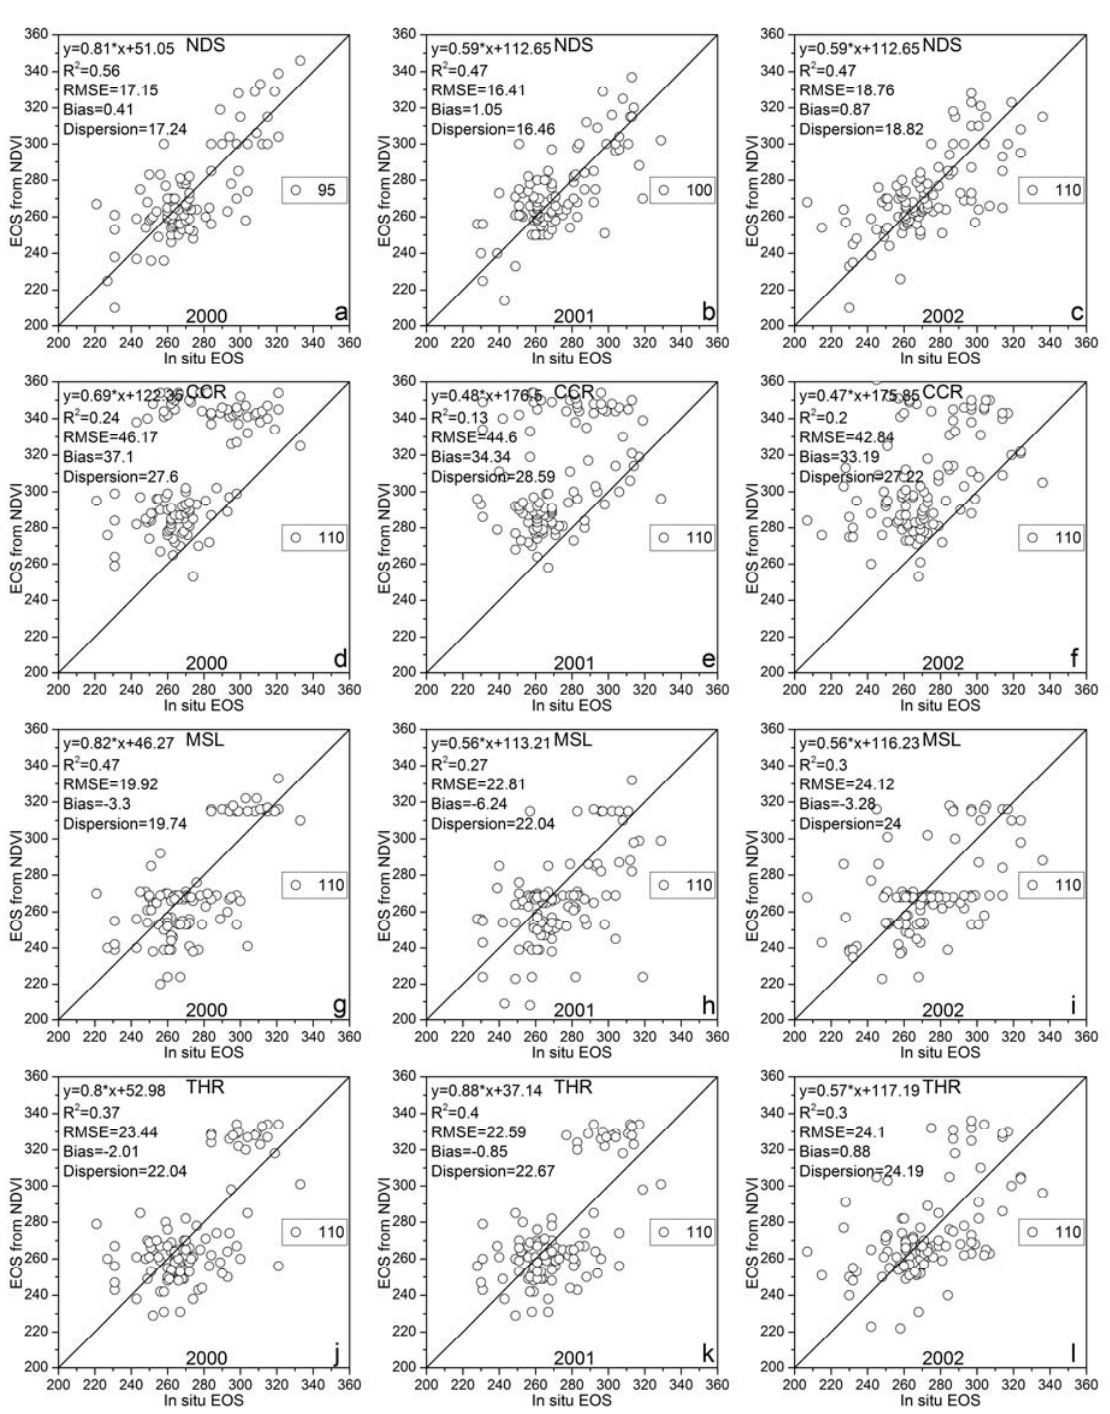
Figure 7. Comparisons of in situ EOS date (DOY) with EOS date (DOY) derived from four methods based on remote sensing data: ( a – c ) This study’s NDS